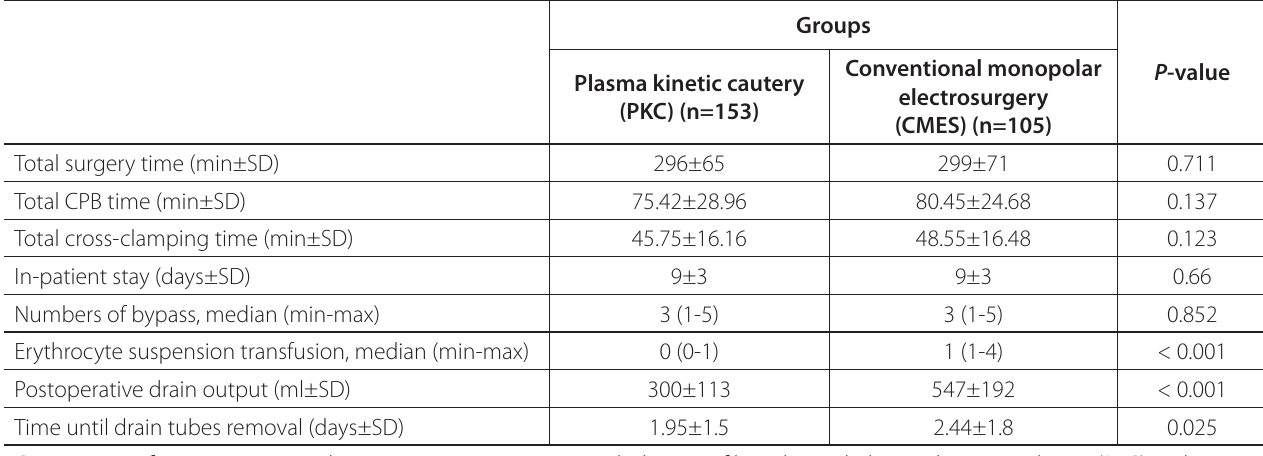
Table 2 . Intraoperative and postoperative data of both dissection techniques.